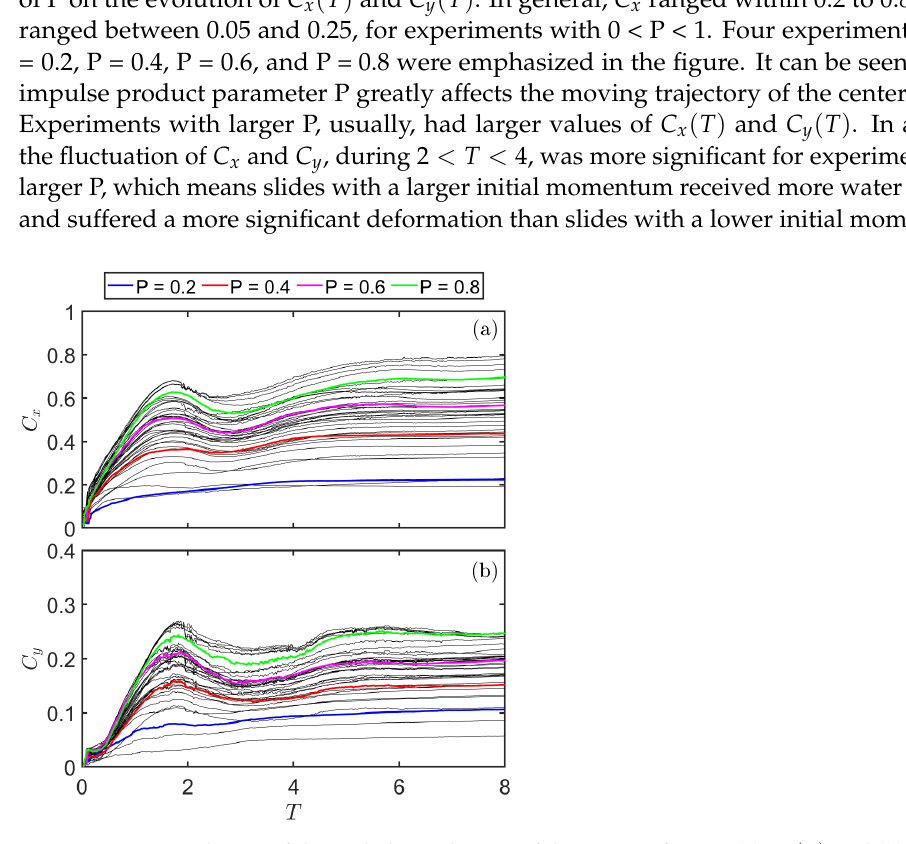
Figure 7. Time evolution of the scaled coordinates of the center of mass: ( a ) C x ( T ) and ( b ) C y ( T )